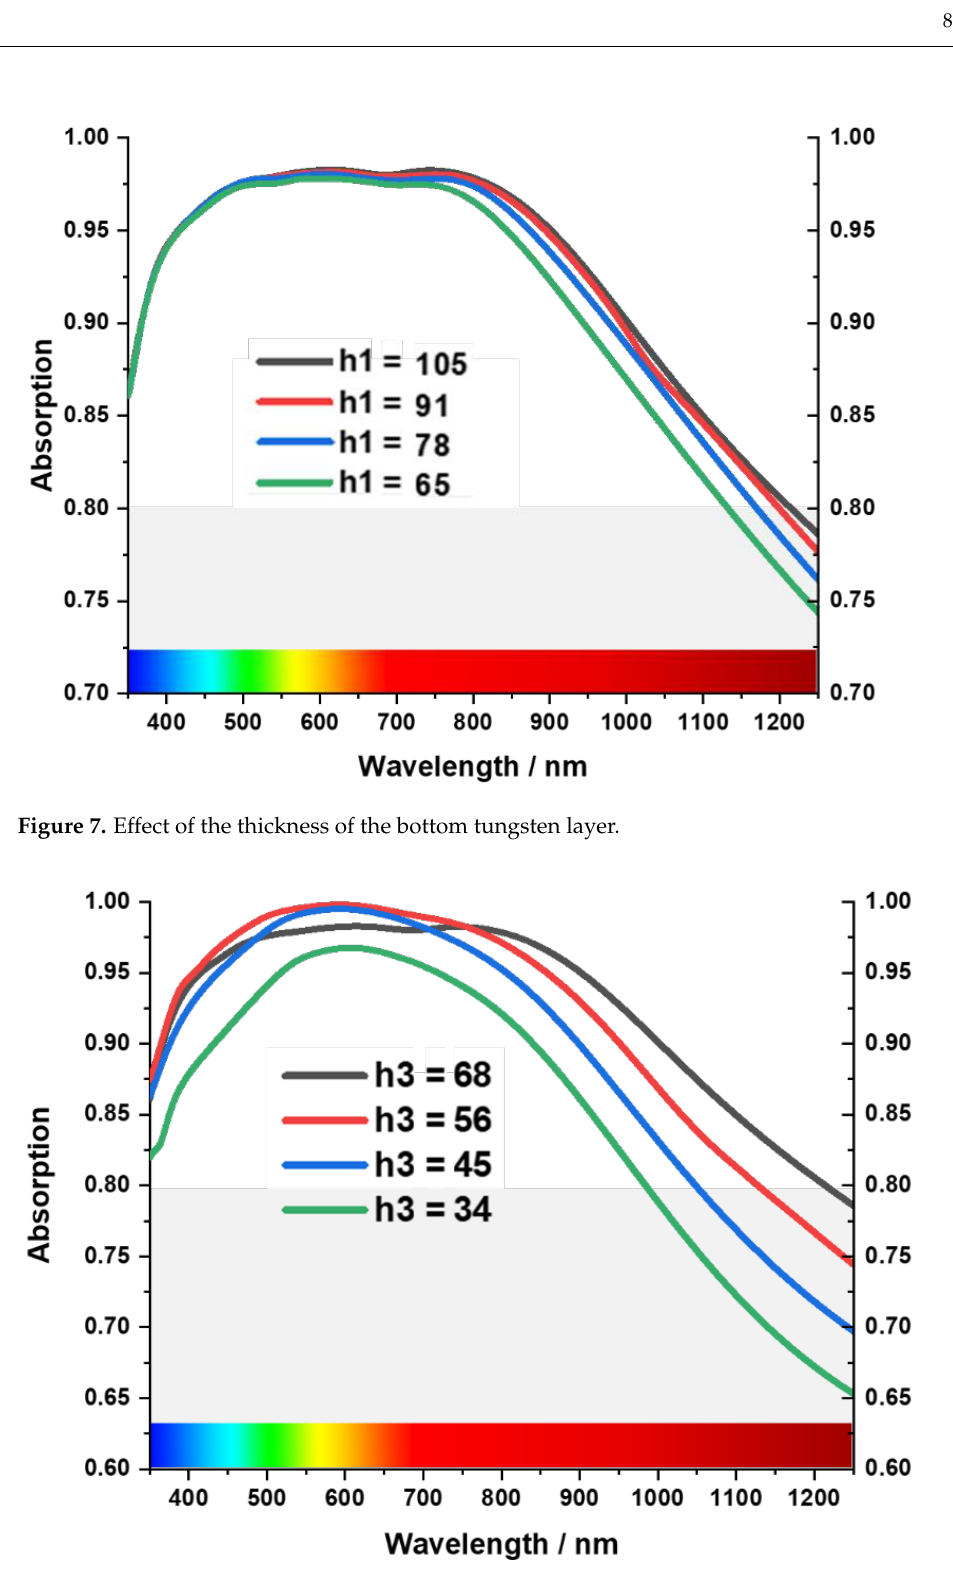
Figure 8. Effect of the thickness of resonating tungsten layer.